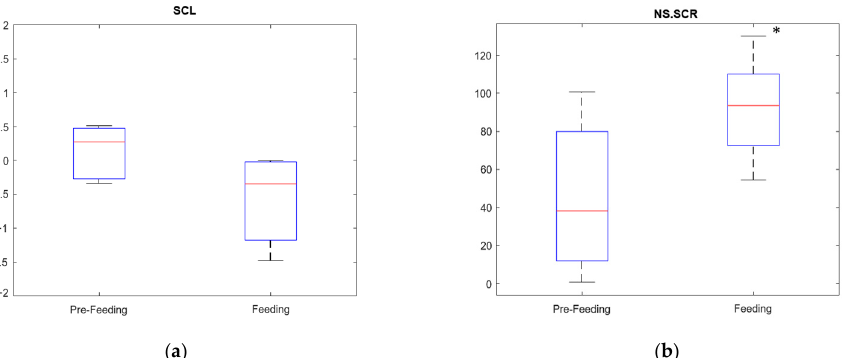
Figure 5. ( a ) Boxplot for SCL at pre-feeding and feeding stages ( p -value = 0.1049). ( b ) Boxplot for NS.SCR at pre-feeding and feeding stages ( p -value = 0.0281). * Represents statistically significantly differences ( p -value < 0.05) between pre-feeding and feeding.